Question: Write a caption explaining this figure to a reader.
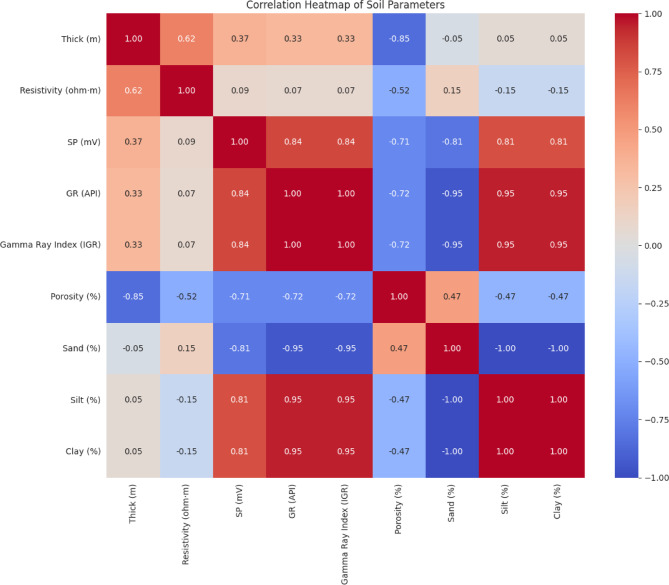
Answer: Pearson correlation matrix of soil and geophysical parameters across all 87 borehole, and ERT stations ( n = 87; Ras El-Hekma study area). Variables included are layer thickness (m), electrical resistivity (ohm·m), spontaneous potential (SP, mV), natural gamma ray (GR, API), gamma ray index (IGR), porosity (%), and grain-size fractions (sand %, silt %, clay %). Grain-size fractions were subjected to centred log-ratio (CLR) transformation prior to correlation analysis to correct for the compositional closure constraint (sand + silt + clay = 100%), which produces spurious correlations in raw fraction data; the uncorrected silt–clay Pearson r of − 1.00 reduces to r = 0.78 after CLR transformation (highlighted by gold borders). Colour scale: dark red = strong positive correlation (r → +1); dark blue = strong negative correlation (r → −1); white = no correlation ( r ≈ 0). All correlations are significant at p < 0.05 unless indicated. Produced using Python (Https://matplotlib.org/; https://seaborn.pydata.org/tutorial/function_overview.html).